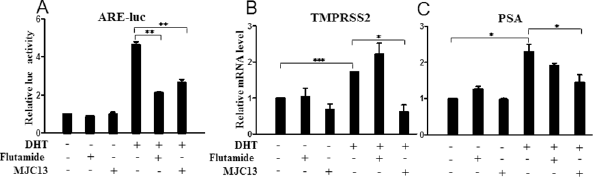
Fig 6. Effects of AR antagonists are blunted in 22RV1 cells. (A) Luciferase activity measured in 22RV1 cells transfected with ARE-luc reporter and treated +/- DHT (1nM), +/- Flutamide (1 μ M), or +/- MJC13 (30 μ M) overnight, with quantities of plasmids as in Fig 1A. All data are representative of at least three independent experiments with similar results. All values represent the mean ± SD of duplicate samples. (B-C) qPCR analysis of 22RV1 cells extracts treated +/- DHT (1nM), +/- Flutamide (1 μ M), or +/- MJC13 (30 μ M) for 24 hours. The data are representative of at least three independent experiments. All values represent the mean ± SD of triplicate samples. Genes are TMPRSS2 (B) and PSA (C).